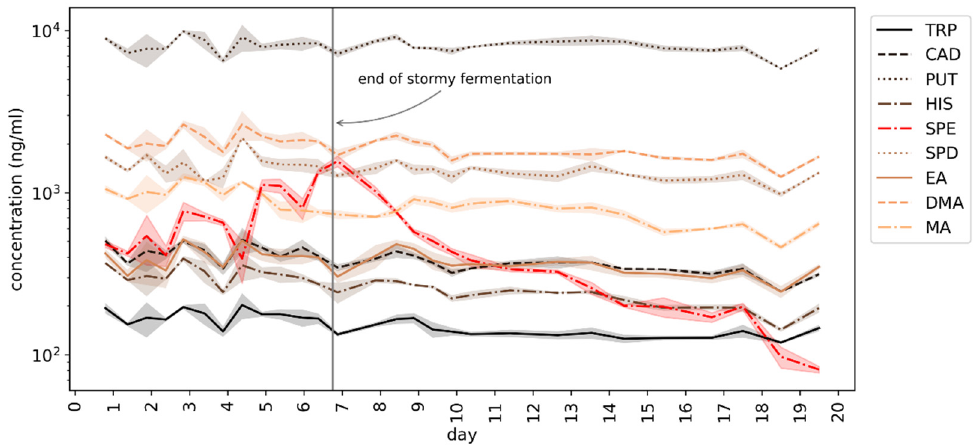
Figure 4. Changes in the concentration of BAs during fermentation of homebrewed ale. Note the logarithmic scale. Shaded areas denote sd ( n = 3).